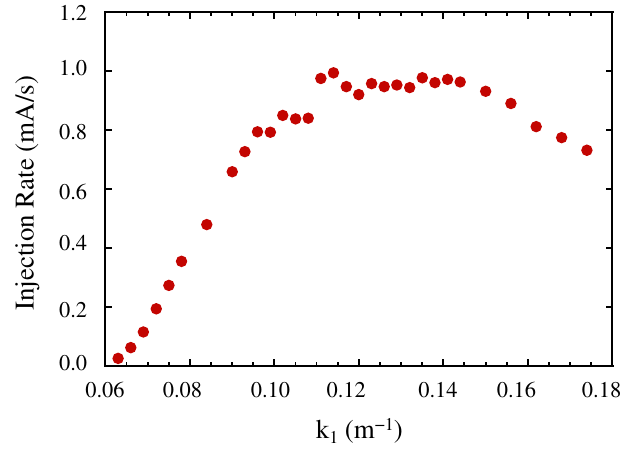
FIG. 21. (Color) Typical coherent dipole oscillation of the stored beam in the horizontal direction measured using a beam detec- tion monitor just after the injection. The output voltage of the monitor is displayed as a function of time. The dipole oscillation after the excitation of the PQM (red solid line) is greatly reduced as compared with that after the excitation of the kickers (blue dashed